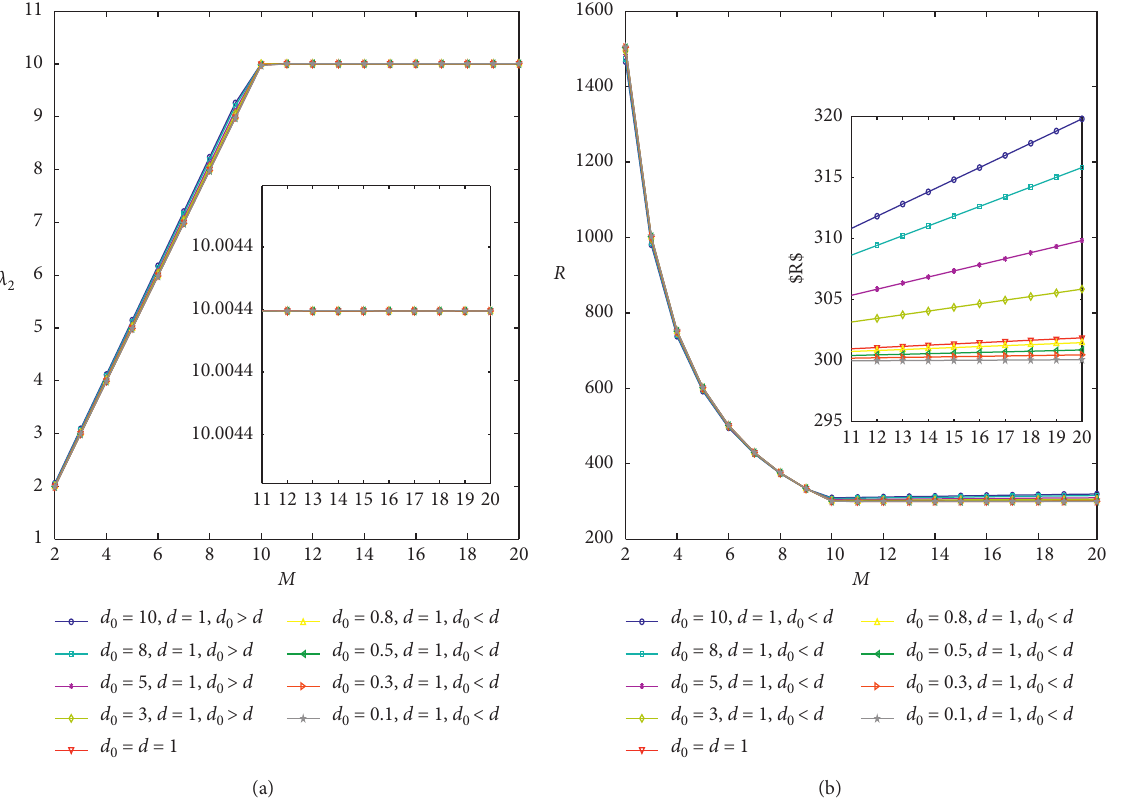
Figure 15: The synchronizability of multilayer star-ring networks vs . varying the number of the layers M ( N � 100, a � 10, and d � 1). (a) λ with respect to varying M for different d 0 . (b) R with respect to varying M for different d 0